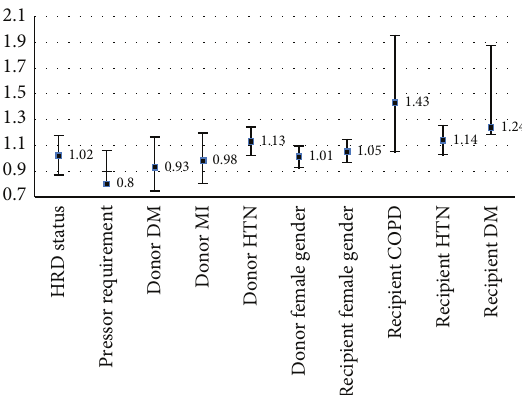
Figure 4: Recipient comorbidities, including DM, COPD, and hypertension (HTN), as well as donor hypertension increase risk of mortality. When controlling for donor and recipient factors, IRD status (HRD) does not independently impact